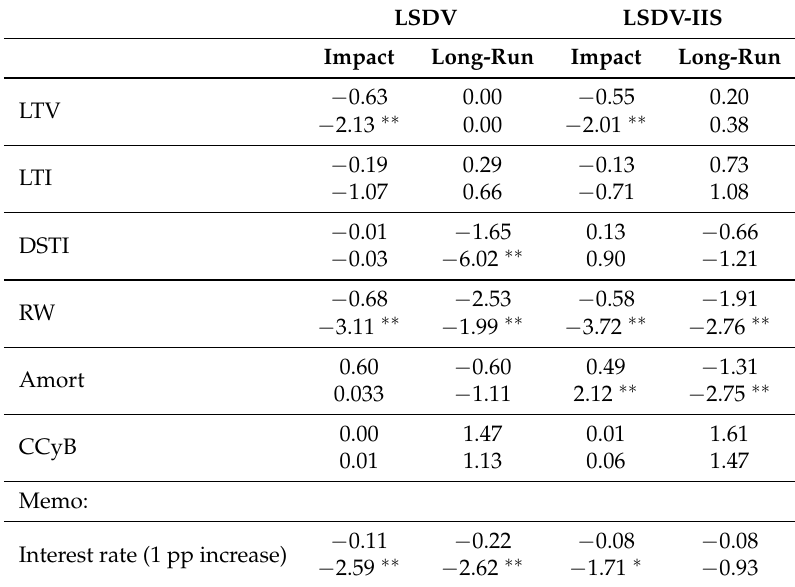
Table 5. Real credit growth. Estimated (LSDV and LSDV-IIS) effects for LTV, LTI, DSTI, RW, Amort and CCyB . Results for the central bank rate shown in the memo part of the table. t-values are shown below the estimated impact and long-run effects. Statistical significance (two sided test) is indicated by ∗∗ (5% level) and ∗ (10% level).